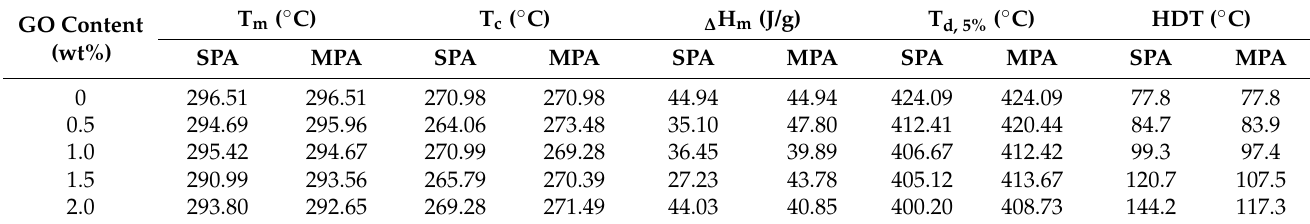
Table 3. Test results of some thermal properties of SPA composites and MPA